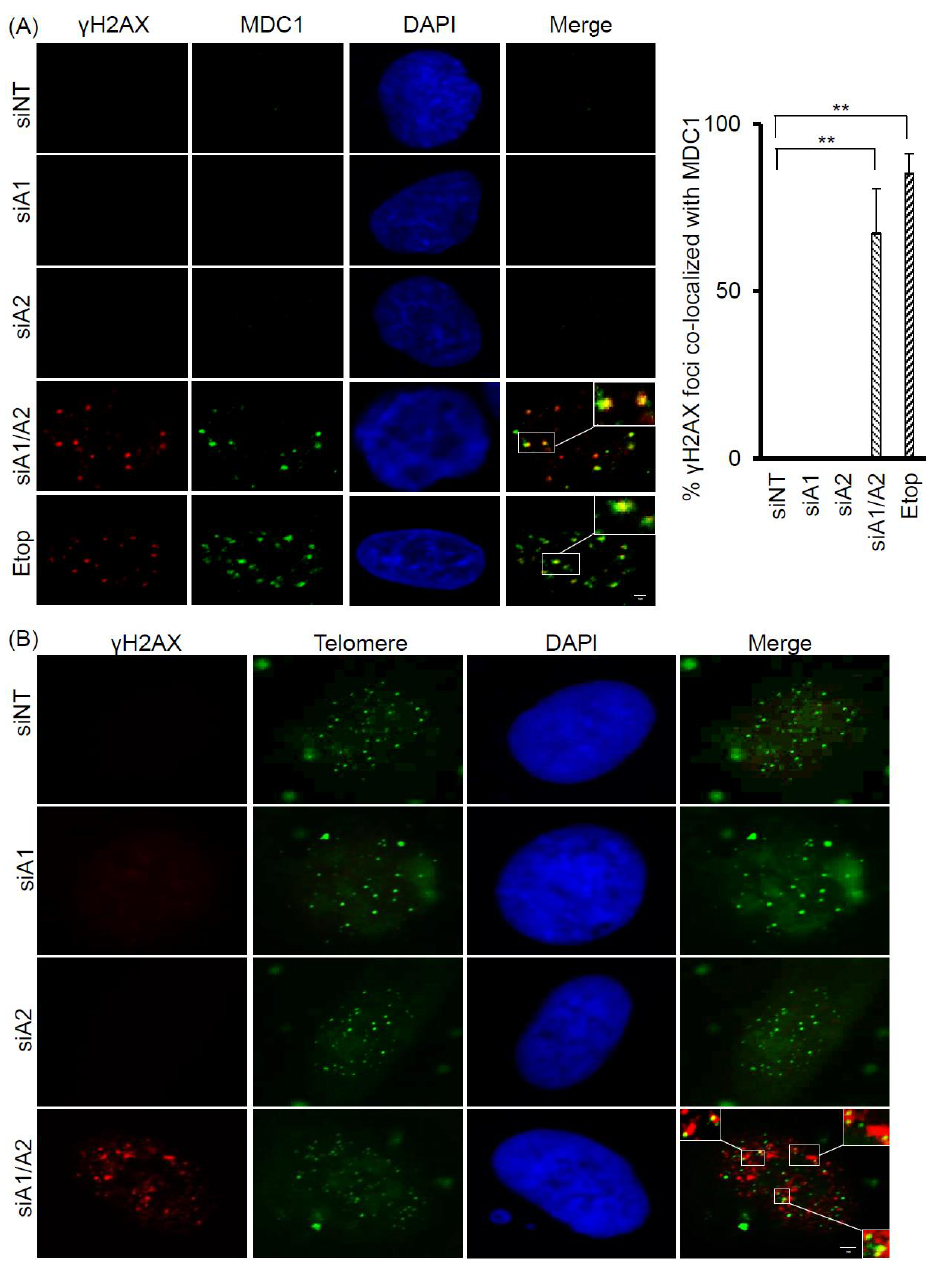
Figure 2. Co-localization of γH2AX with MDC1 and telomere DNA in A549 cells depleted of hnRNP A1/A2. ( A ) A549 cells were transfected with siRNA targeting hnRNP A1 (siA1), hnRNP A2 (siA2), both hnRNP A1 and A2 (siA1/A2), or with a non-targeting sequence (siNT) for 72 h. Cells were fixed and immunostained for γ H2AX (red) and MDC1 (green), and nuclei were counterstained with DAPI (blue). A549 cells treated with 50 µ M etoposide (Etop) for 12 h served as a positive control. The percentage of γ H2AX foci that co-localized with MDC1 (see marked squares for examples) was determined from 50 γ H2AX-positive nuclei; data from 3 experiments are summarized in the right panel. ** p < 0.01 versus siNT control; The bar equals 2 µ m.( B ) Cells were stained for γ H2AX (red) and then for telomeric DNA using FISH with fluorescein isothiocyanate (FITC) -conjugated oligonucleotides (green). γ H2AX foci that colocalized with telomere DNA are illustrated in the boxed regions. The scale bar equals 2 µ m.